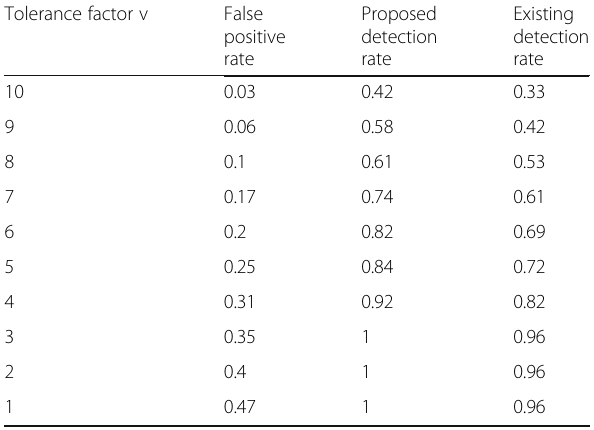
Proposed Existing positive detection detection rate rate